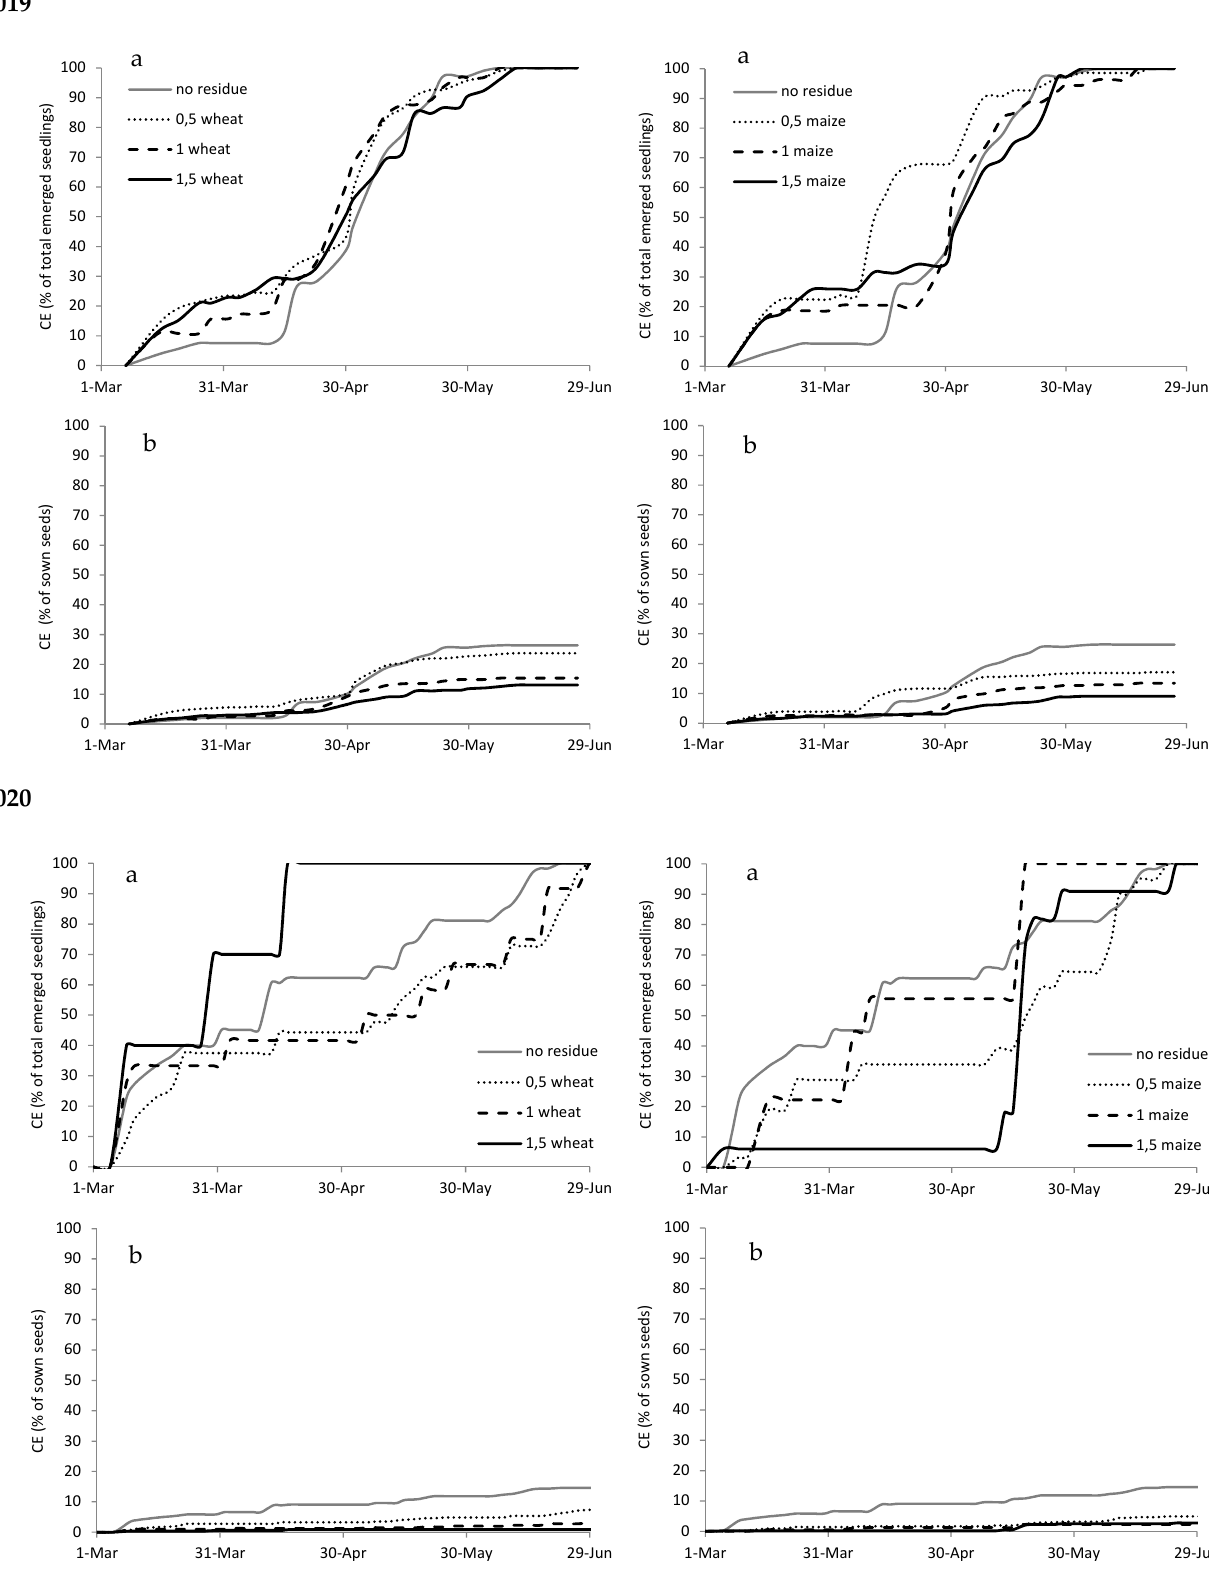
Figure A3. Cumulated emergence (CE) expressed as percentage of total emerged seedlings ( a ) and as percentage of sown seeds ( b ) of Chenopodium album in 2019 and 2020 with different types (wheat on the left and maize on the right) and amounts of crop